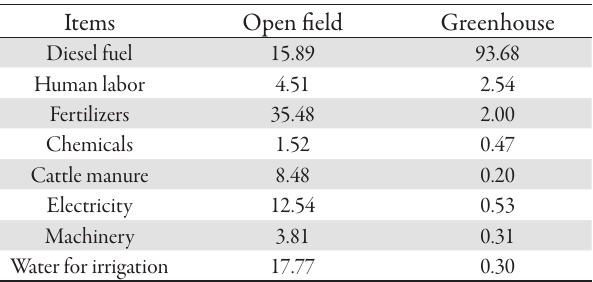
Tab. 6. Total energy input in the form of direct, indirect, renewable energy for open field and greenhouse tomato production systems Type of